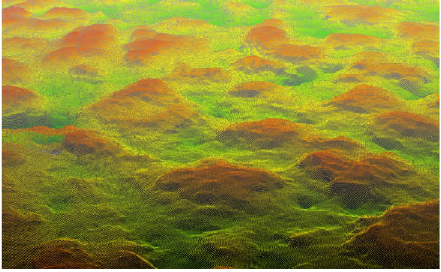
Figure 5. Example of a 3D texture measurement: 3D view of single aggregates (the height is